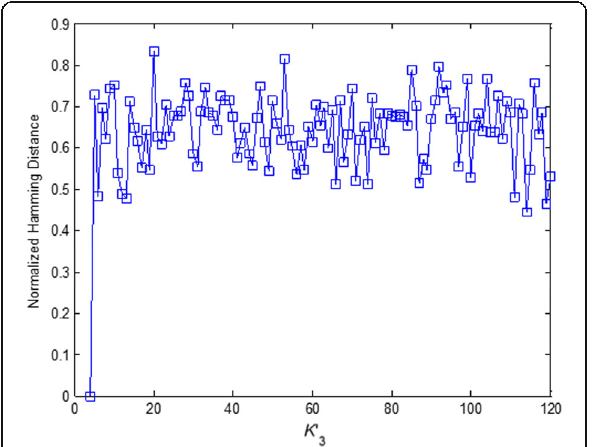
Fig. 12 Distance between hashes using a different key